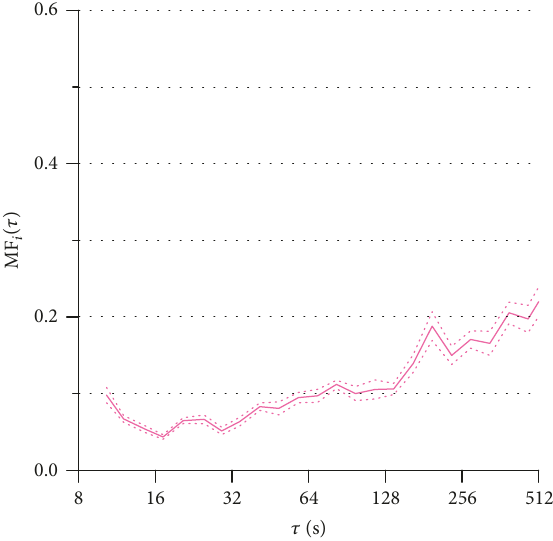
Figure 11: Multifractal index of pink noise . Median ± standard error of the median for the 100 synthesized series of Figure 10.